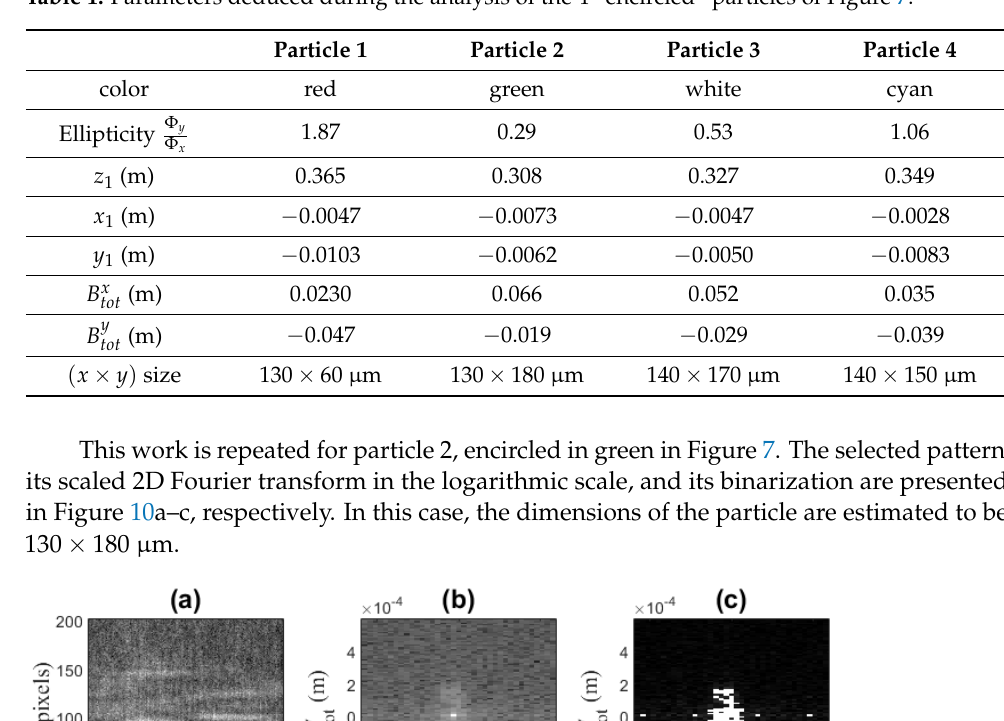
Table 1. Parameters deduced during the analysis of the 4 “encircled” particles of Figure 7.